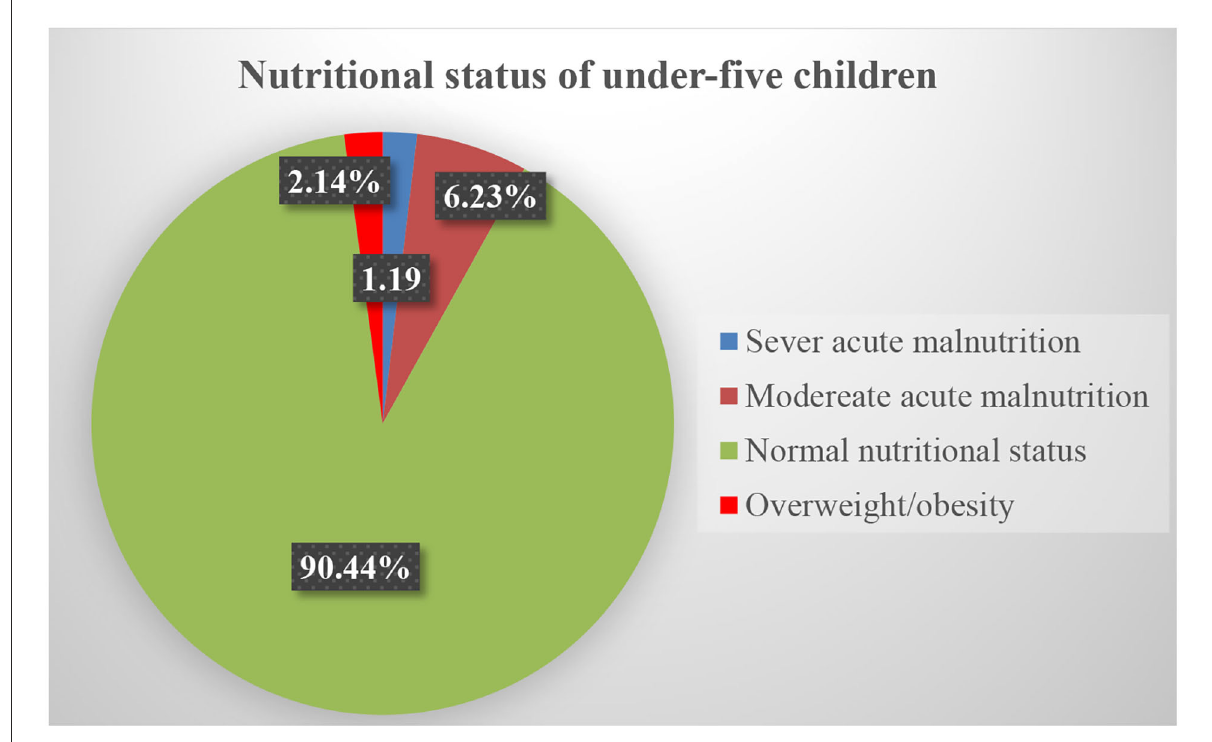
FIGURE1 Nutritional status in under-five aged children in Ethiopia: Data from Ethiopia Mini Demographic and Health Survey (EMDHS 2019).